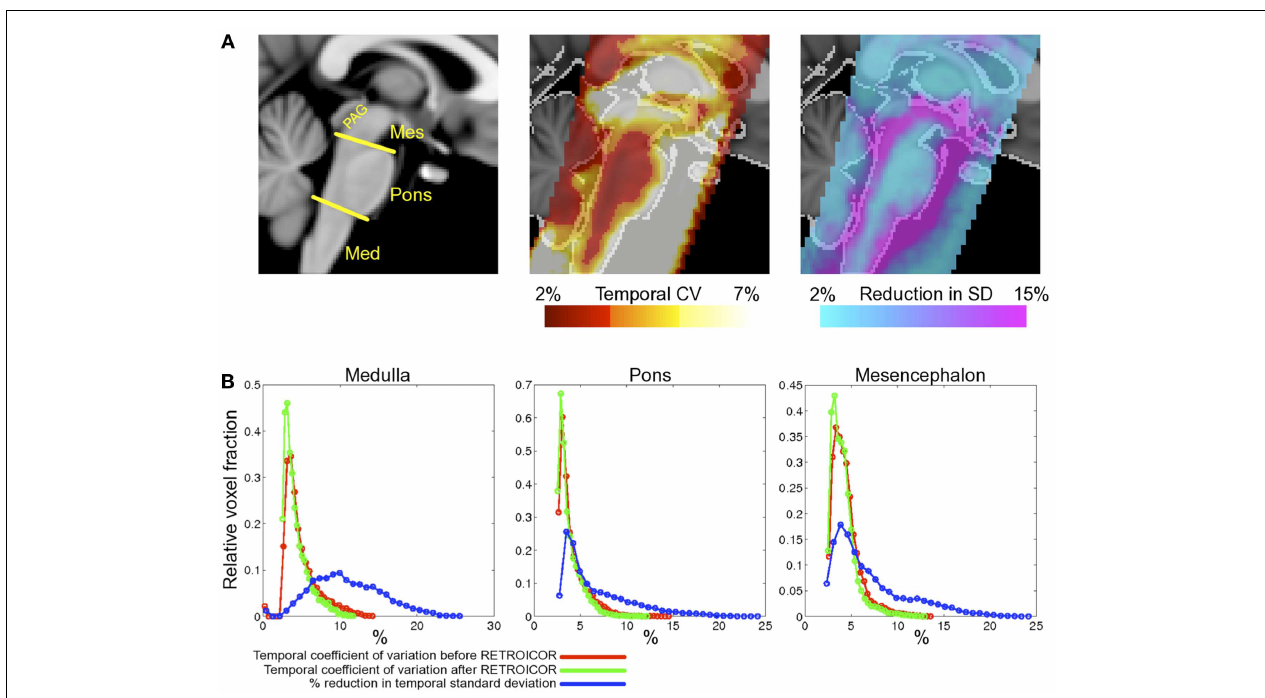
variance was found in and around the PAG and the edges of the pons and medulla.The lower portion of the figure (B) shows histograms of the temporal coefficient of variation for both the uncorrected (red) and corrected (green) resting data in the three brainstem regions examined.Voxel counts were normalized to the total number of voxels in each region. Also shown for each region is the histogram of percentage reduction in temporal standard deviation (blue), and demonstrates that the largest benefit of physiological noise modeling occurred in the medulla, where the proportion of voxels with a reduction in SD greater than 10% is largest, although clearly modeling was beneficial in pons and mesencephalon also. (Reproduced from Harvey et al.,